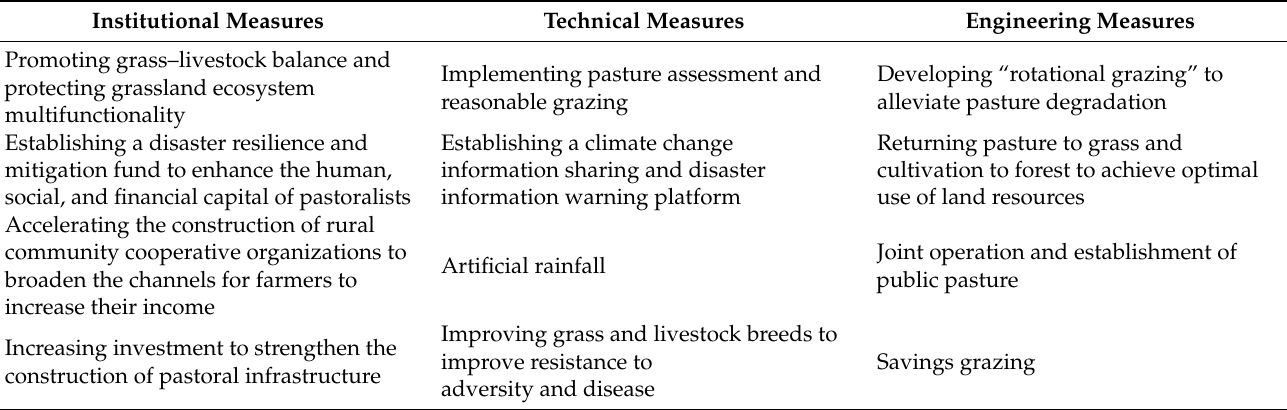
Table 5. Adaptive management measures for climate change in pastoral